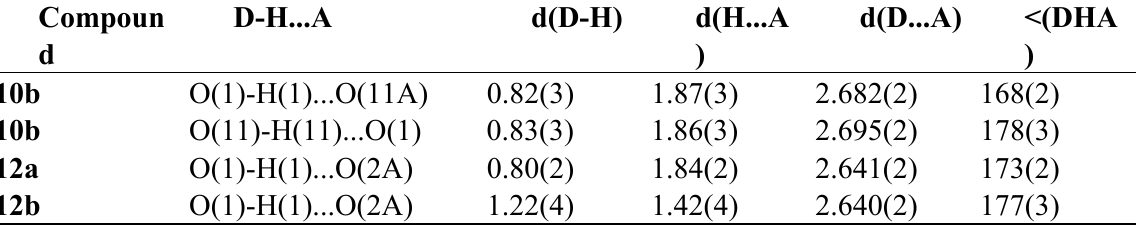
Table 2. Hydrogen-bonding geometry [Å,